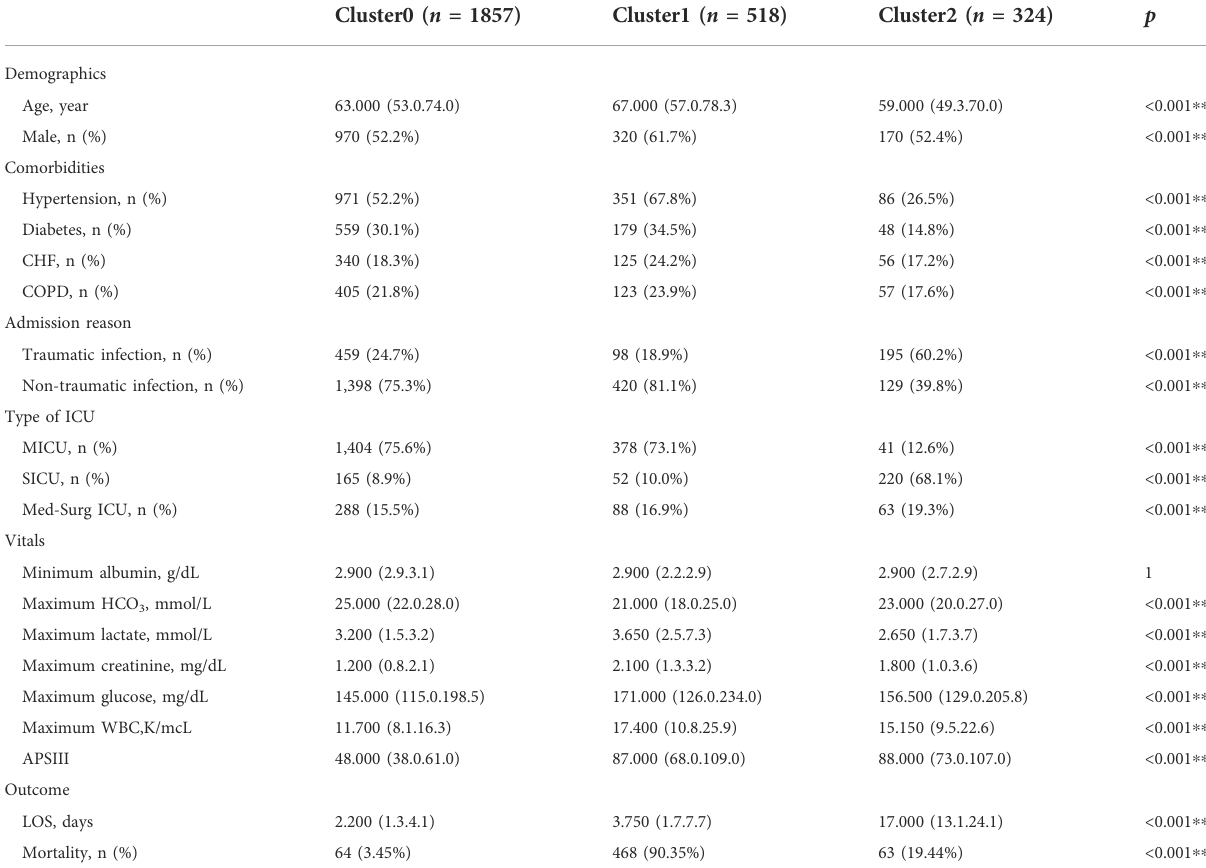
TABLE 5 Clinical characteristics and outcomes of three phenotypes in the MIMIC-IV derivation